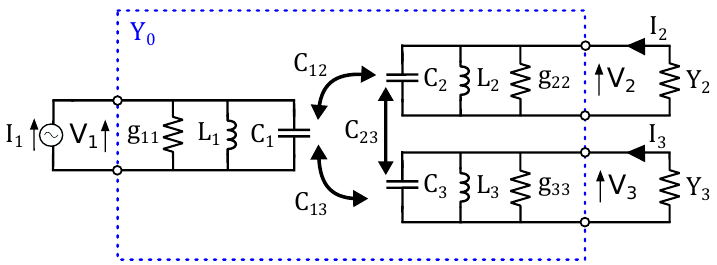
Figure 2. Equivalent circuit to a capacitive wireless power transfer (CWPT) system with one transmitter and two